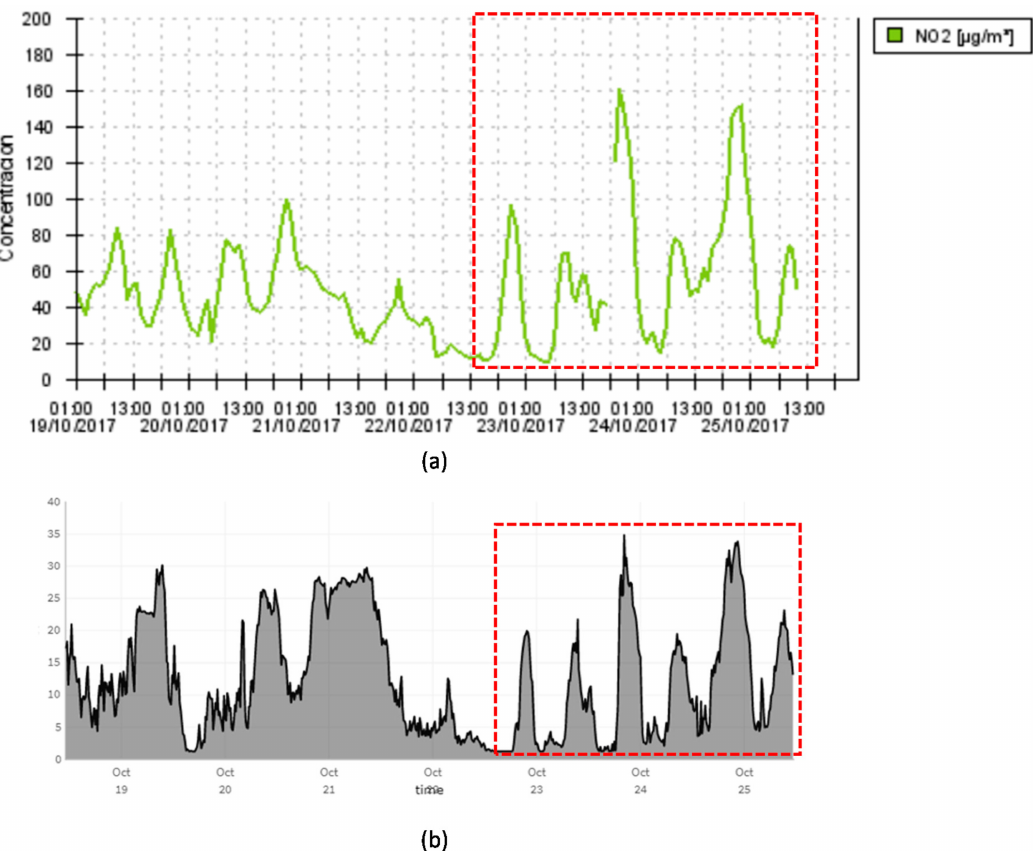
Figure 17. ( a ) NO 2 concentration measured by a municipal air quality monitoring station [51]; ( b ) NO